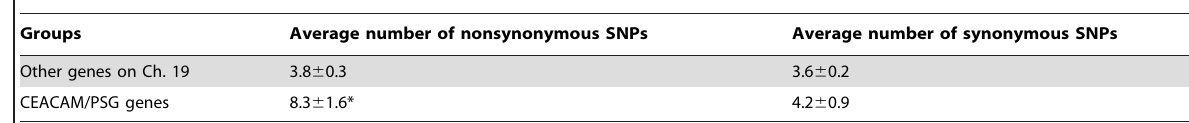
Table 1. CEACAM/PSG family genes have a high density of nonsynonymous SNPs.